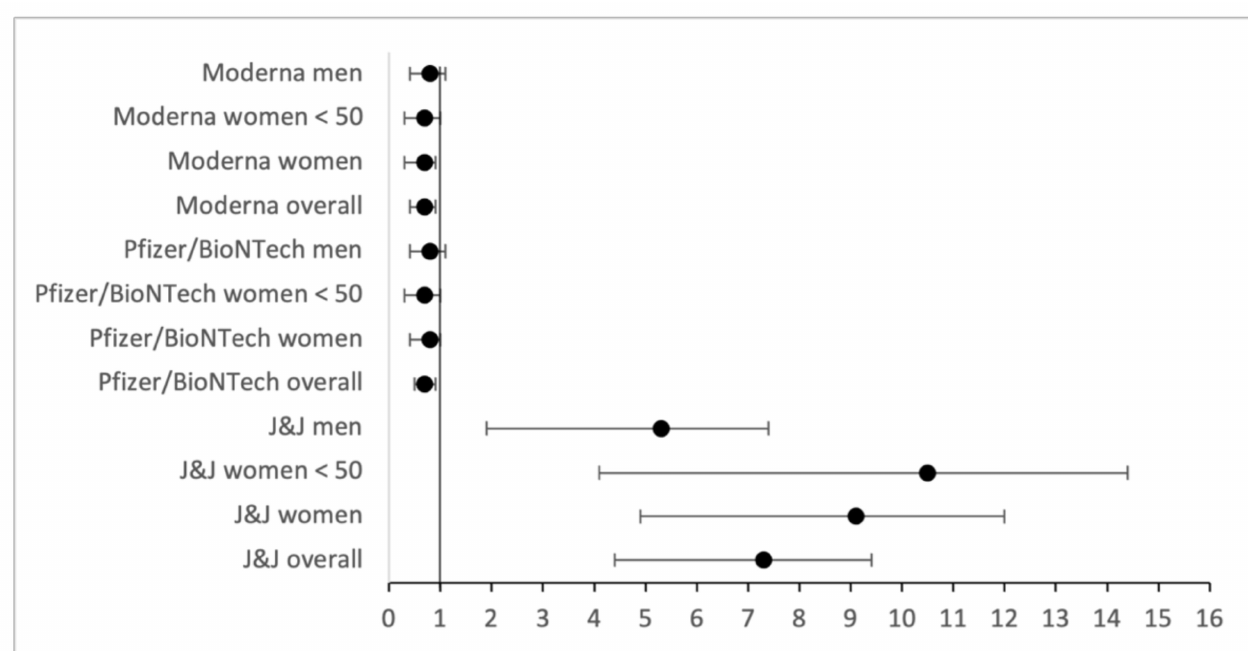
Figure 1. Odds ratios and confidence intervals for CVST, based on a general incidence of 13.2